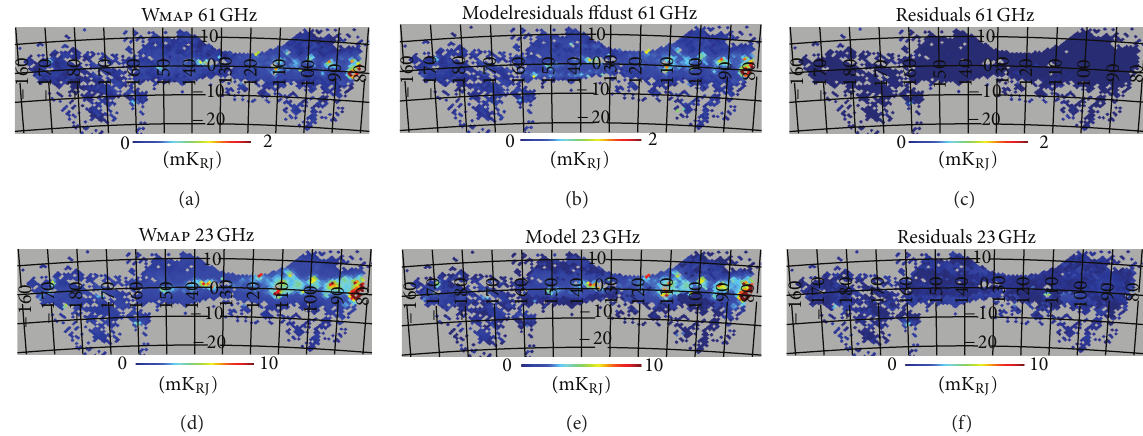
Figure 3: From left to right: residuals after subtraction of the thermal dust and free-free and anomalous emission models for the 61 (top) and 23 GHz (bottom) maps. Table 1: Rms of the high-frequency data and of the residuals after subtraction of the dust model. Frequency (GHz)